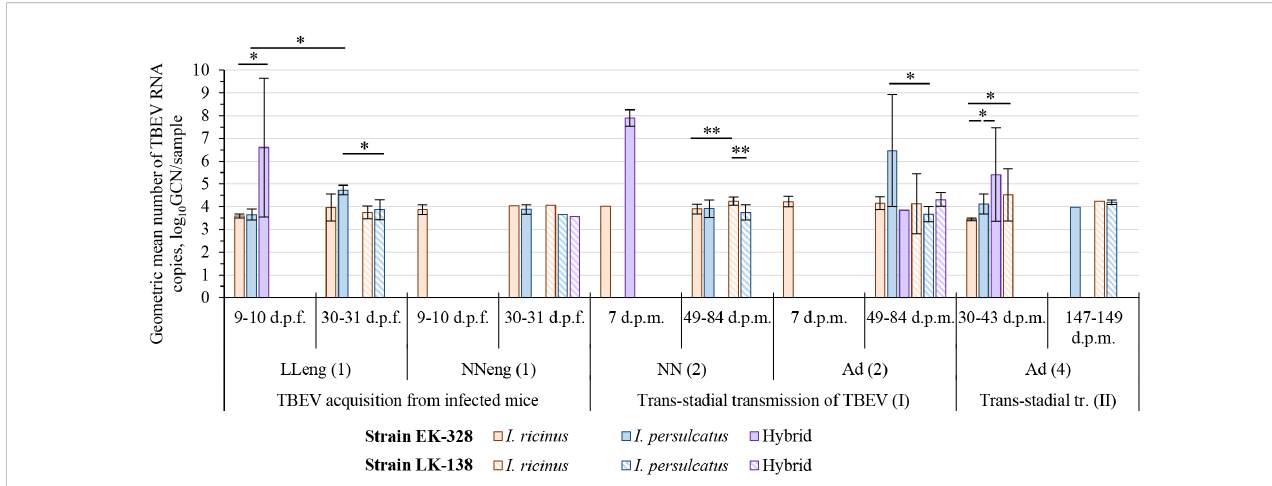
FIGURE 3 Geometric mean number of TBEV RNA copies in tick samples at different period after feeding/molting. Engorged larvae (LL eng (1)) and questing nymphs (NN (2)) were studied in pools of three individuals, engorged nymphs (NN eng (1)) and questing adults (Ad (2), Ad (4)) were analyzed individually; the number of TBEV RNA copies is shown for sample (a pool or individual tick). Whiskers show standard deviation; signi fi cant differences between groups according to Mann – Whitney U-test (2 groups) or Kruskal-Wallis H-test (3 groups): * p<0.05, ** p<0.001; d.p.f. — days post feeding on TBEV infected